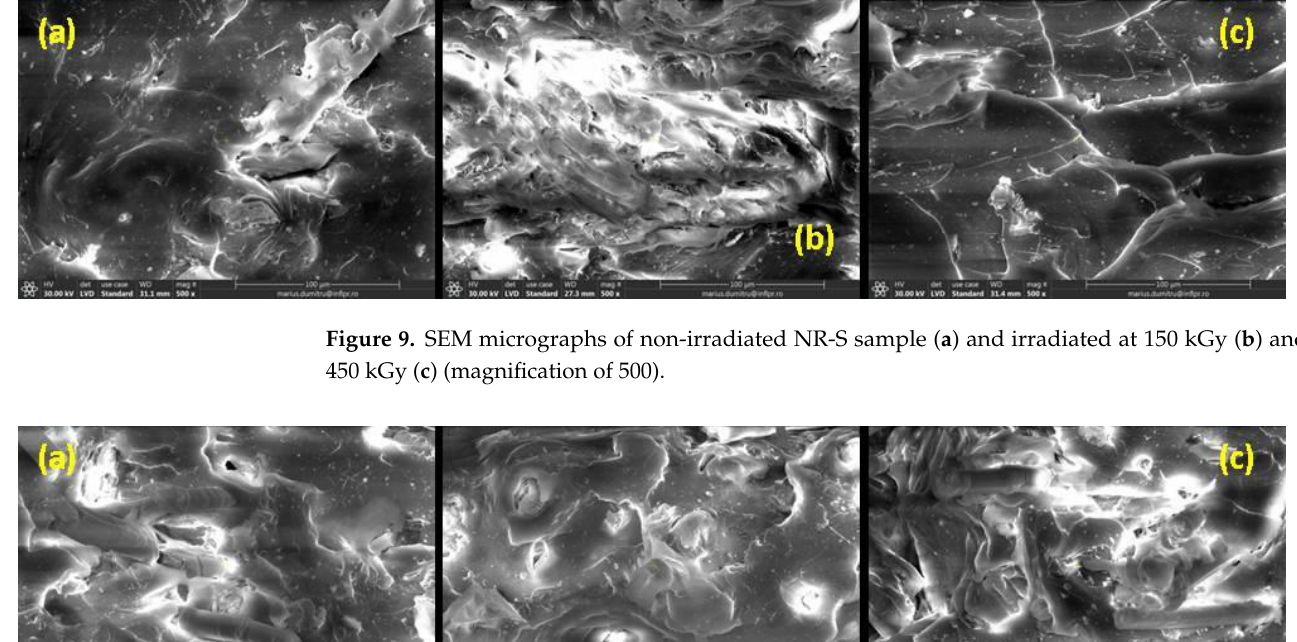
450 kGy ( c ) (magnification of 500).